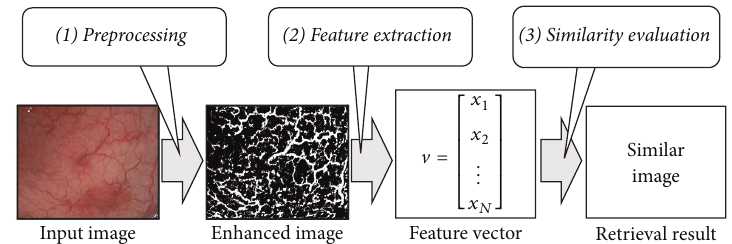
Figure 1: Overview of the basic retrieval